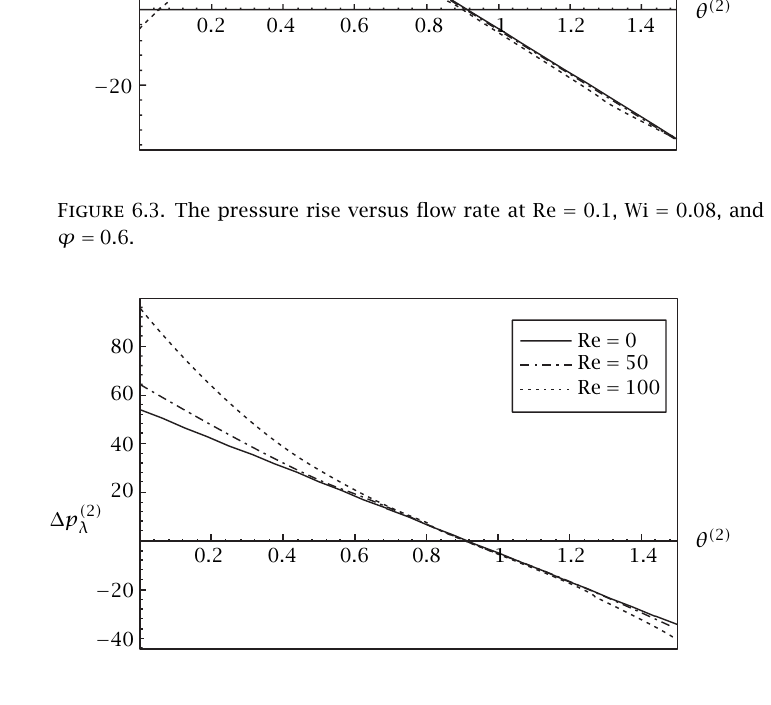
Figure 6.4 . The pressure rise versus flow rate at Wi = 0, δ = 0 . 02, and ϕ = 0 .